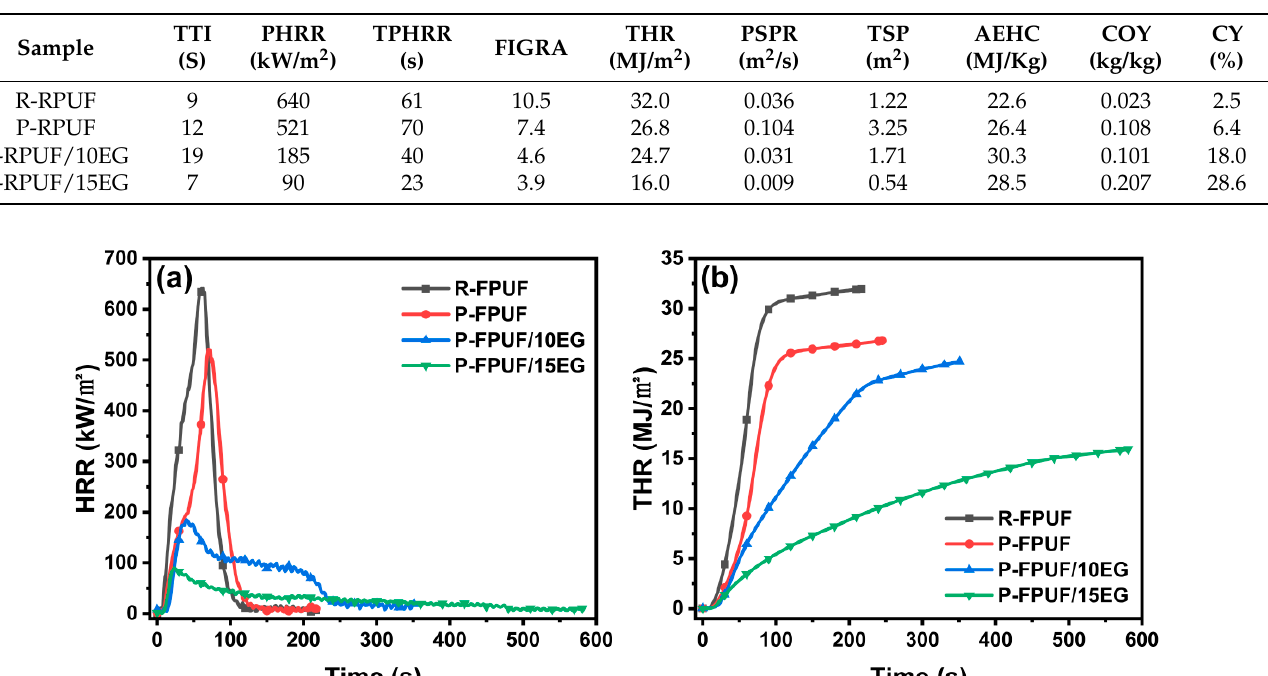
Figure 5. Heat release rate ( a ) and total heat release ( b ) curves for FPUFs under an external heat flux of 25 kW/m 2 .